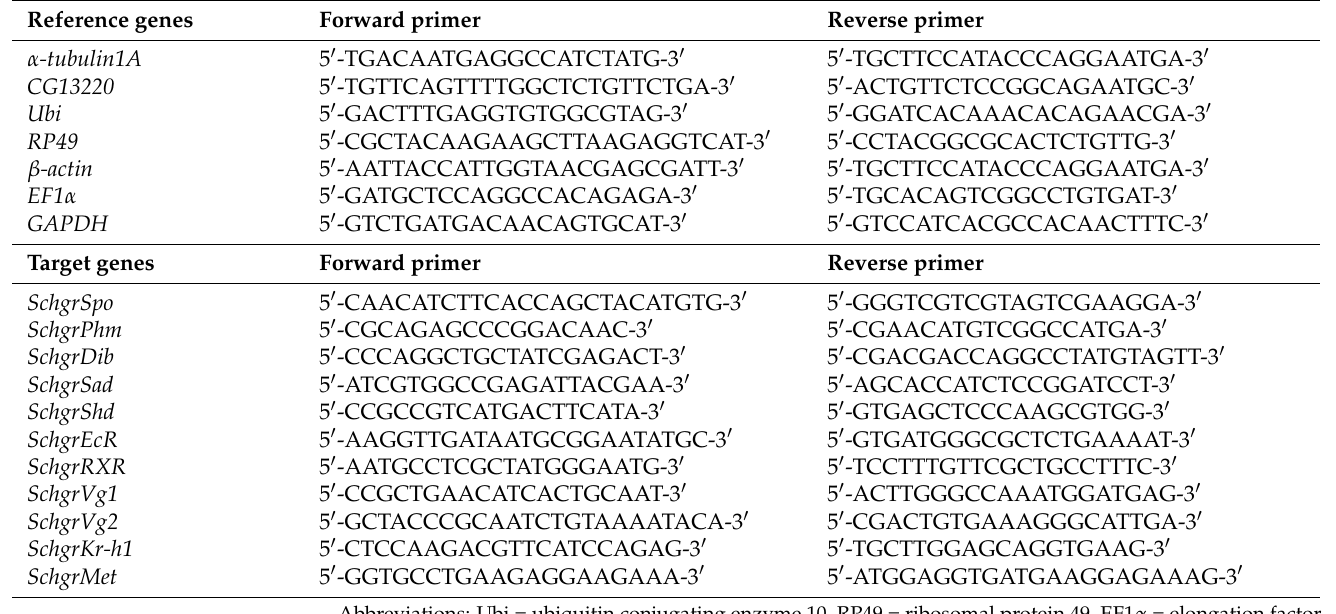
Table A1. Oligonucleotide sequences of primers used in qRT-PCR.